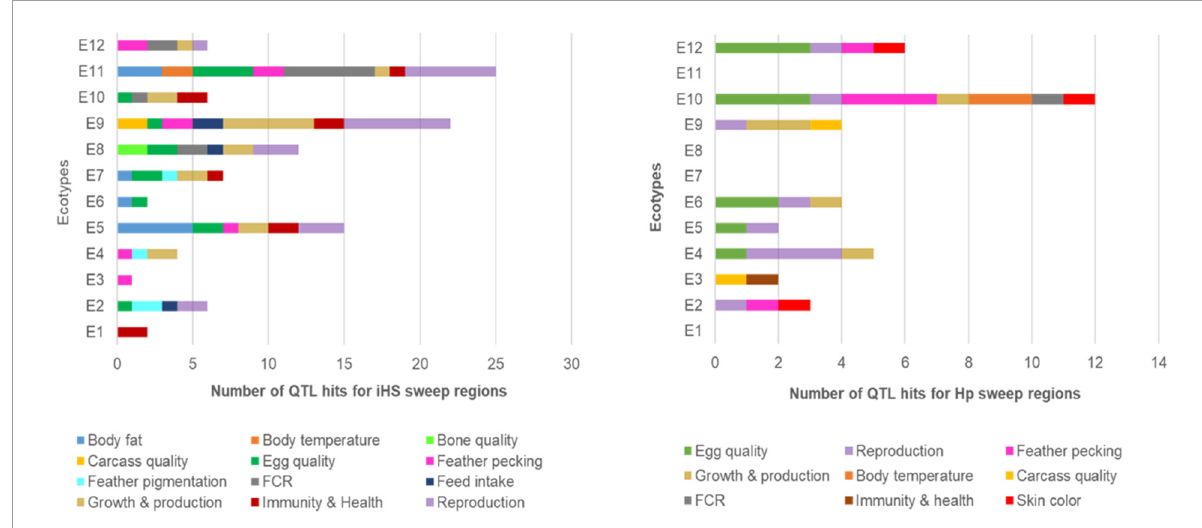
FIGURE6 Overlap of the sweep regions from Hp and iHS analyses with chicken